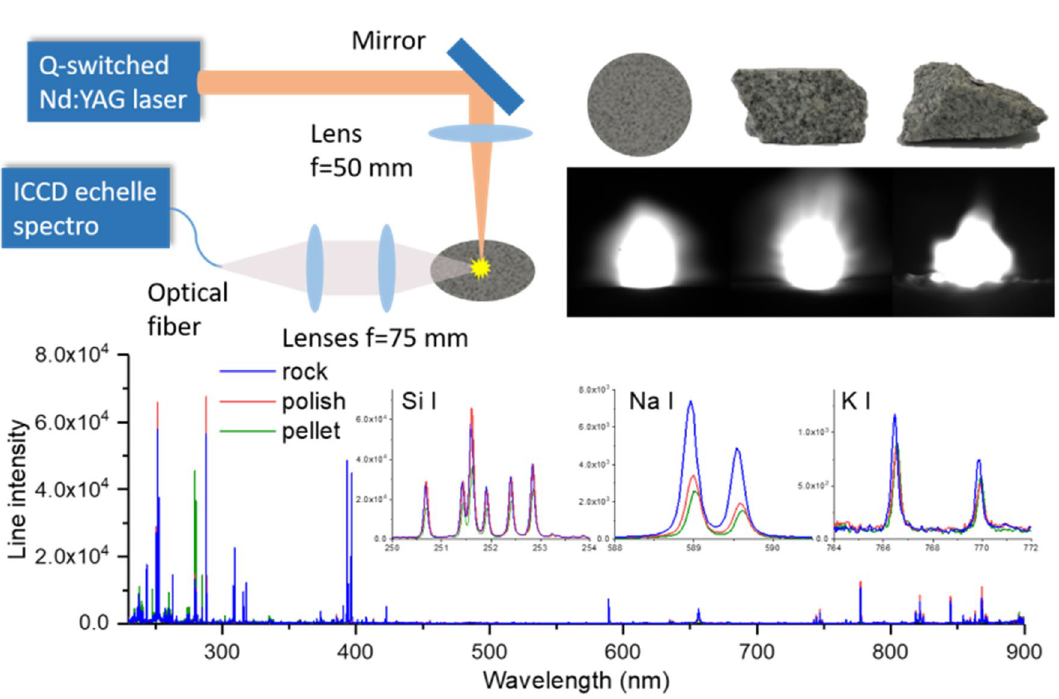
Figure 2. Schematic presentation of the used experimental setup, together with integrated plasma images respectively induced on a pellet, a polished rock and a raw rock of a typical sample (S1), and the corresponding replicate-averaged raw spectra showing differences in average emission intensities of Si, Na and K between a pellet and the corresponding polished and raw